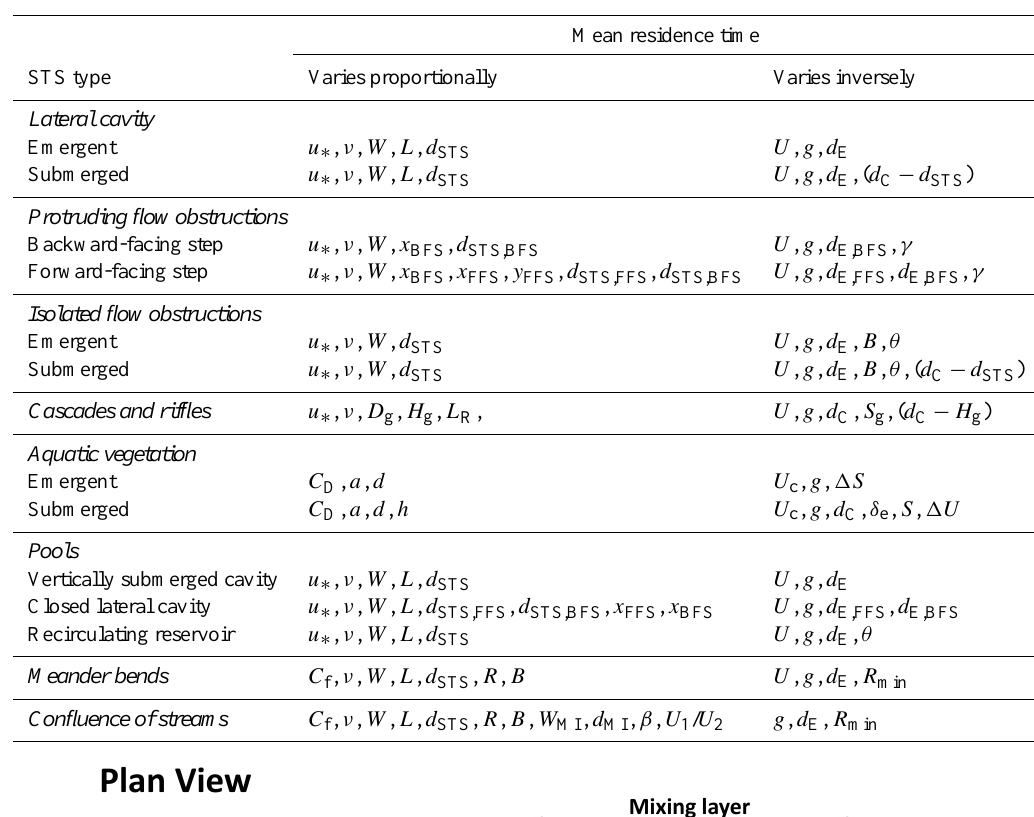
Table 2. Summary of qualitative relations between mean residence time ( τ ) and case-specific parameters for each STS type.